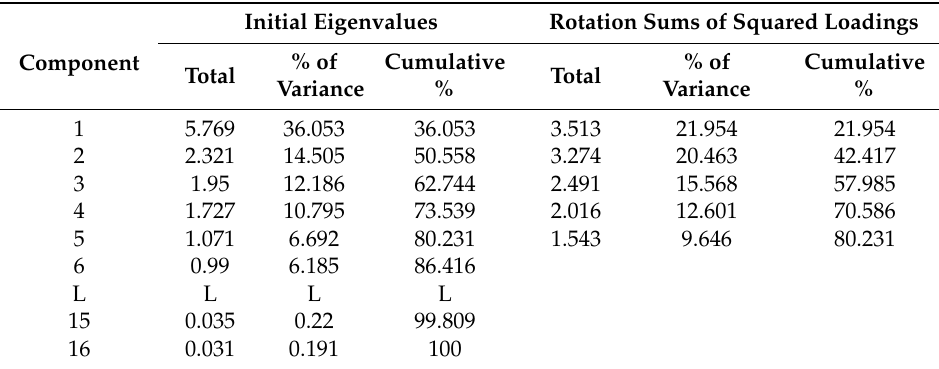
Table 2. Total variance explained of self-sustainable capacity.